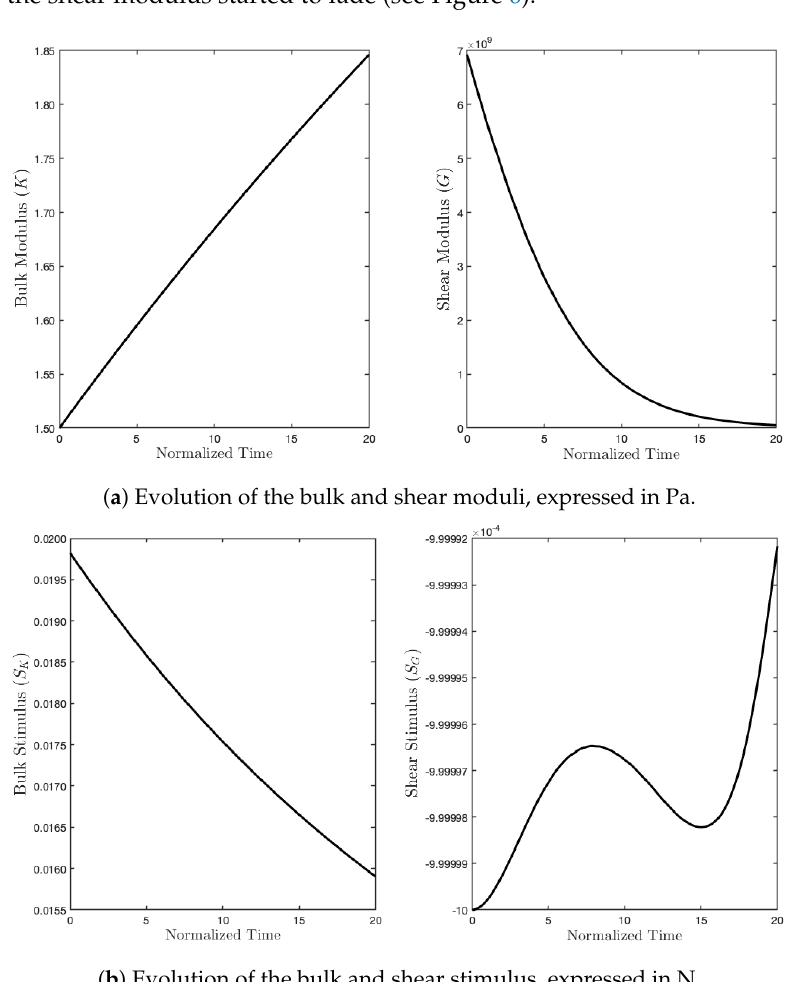
Figure 6. Evolution of moduli and stimuli in time for the purely hydrostatic